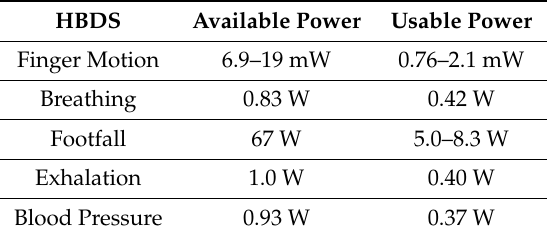
Figure 8. Different EHS that can be developed from a human body. Figure 8. Di ff erent EHS that can be developed from a human body. Table 5. A summary of the power generated from human body-driven sources Table 5. A summary of the power generated from human body-driven sources (HBDS).